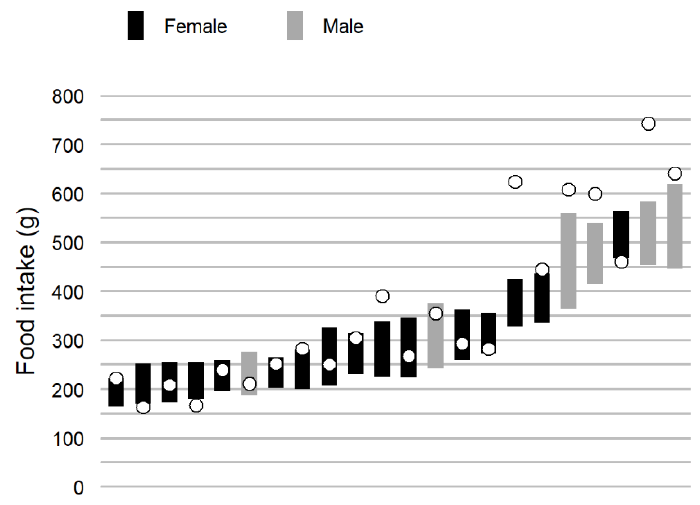
Figure 2. Confidence intervals for food intake weight of each participant, arranged in ascending order. Based on all real-life meal recordings, only including participants with ≥ 7 recordings. The white dots represent the single school lunch recording of each participant.